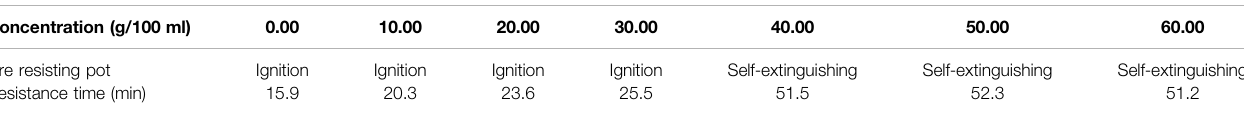
TABLE 1 | Fire resistance performance test results of composite foam with different concentration talc particles. Concentration (g/100